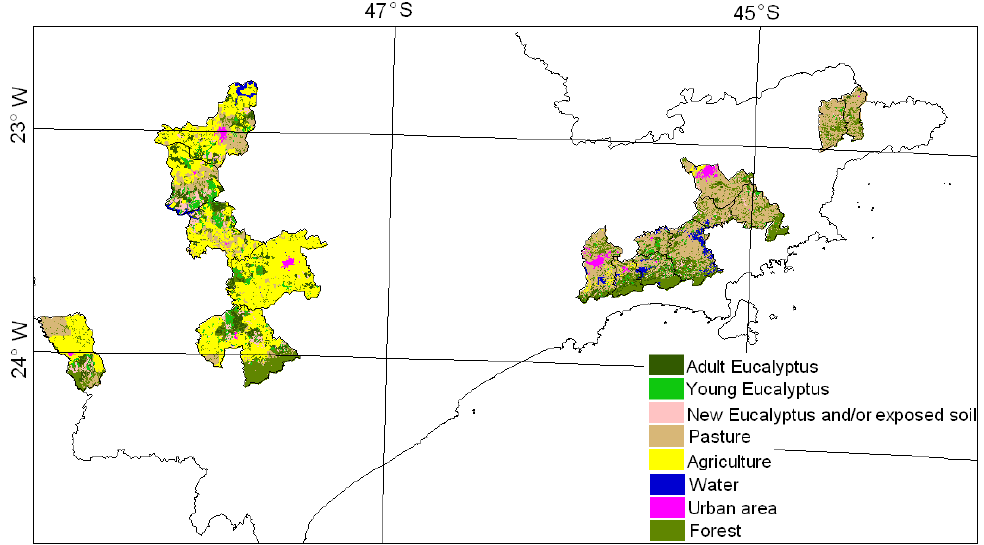
Figure 5. Land use and land cover map for the studied